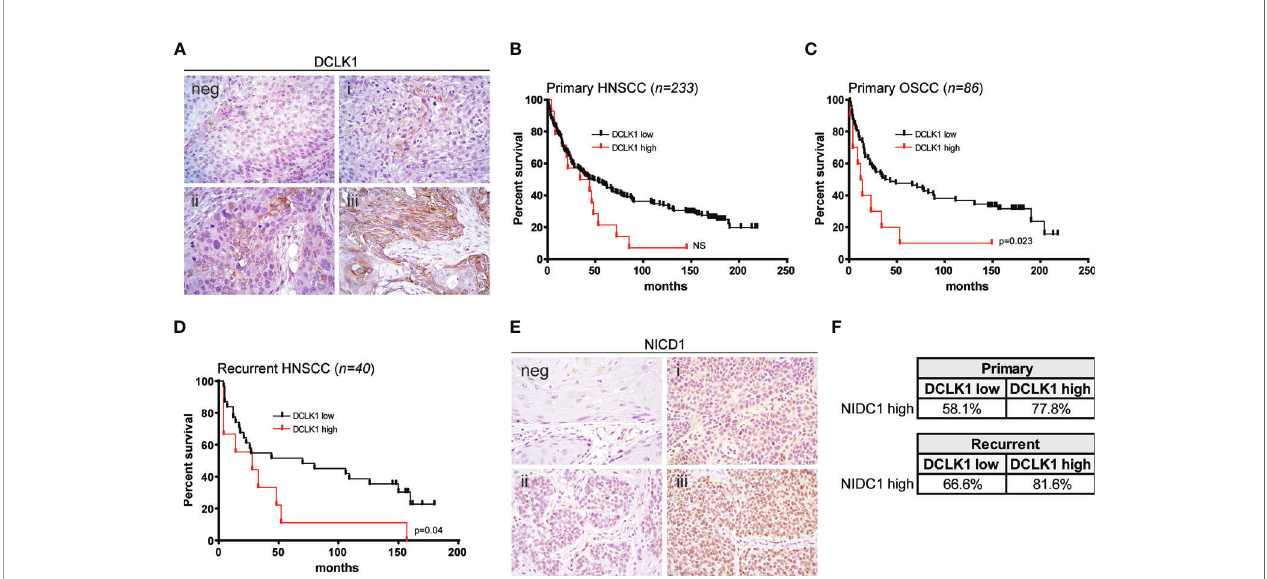
FIGURE 6 | Expression of DCLK1 is associated with poor prognosis in patients with HNSCC. (A) Representative staining of DCLK1 in HNSCC tumors: (neg) negative, (i) weak, (ii) moderate, (iii) high expression. (B) Kaplan Meier estimates of overall survival based on DCLK1 protein expression status in a cohort of 233 primary HNSCC tumors. Low expression (negative and weak staining) - black line, high expression (moderate and high staining) - red line. (C) Kaplan – Meier estimates of overall survival based on DCLK1 protein expression status in a cohort of 86 primary OSCC tumors. Low expression (negative and weak staining) - black line, high expression (moderate and high staining) - red line (p = 0.023). (D) Kaplan – Meier estimates of overall survival based on DCLK1 protein expression status in a cohort of 40 recurrent HNSCC tumors (low expression - black line, high expression - red line) (p = 0.04). (E) Representative staining of NICD1 in HNSCC tumors: (neg) negative, (i) weak, (ii) moderate, (iii) high expression. (F) Table demonstrates a higher percentage of tumors with high NICD1 staining, among patients that also demonstrate higher DCLK1